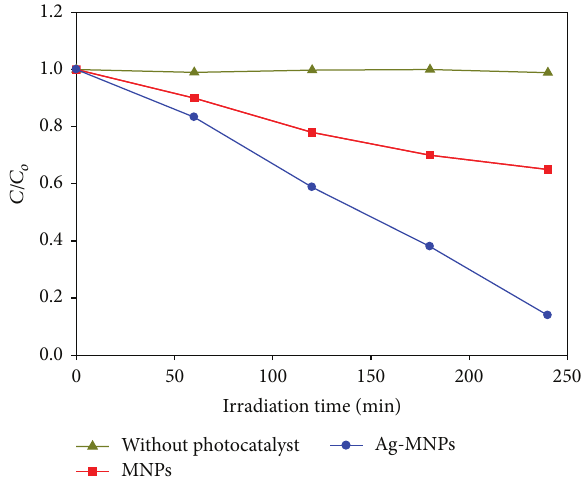
Figure 9: Photodegradation of eosin Y as a function of irradiation time in the absence and presence of MNPs or